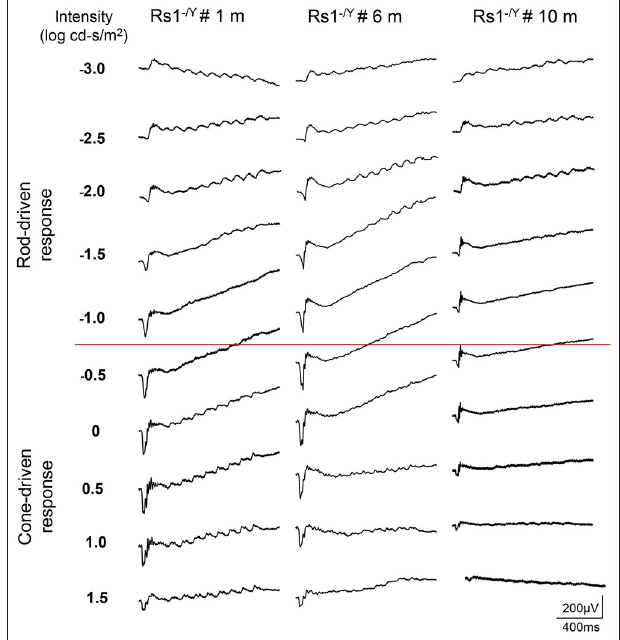
FIGURE 6 | Dark-adapted 10-Hz flicker ERGs elicited with a series of light intensity in Rs1 − / Y mice of different ages.